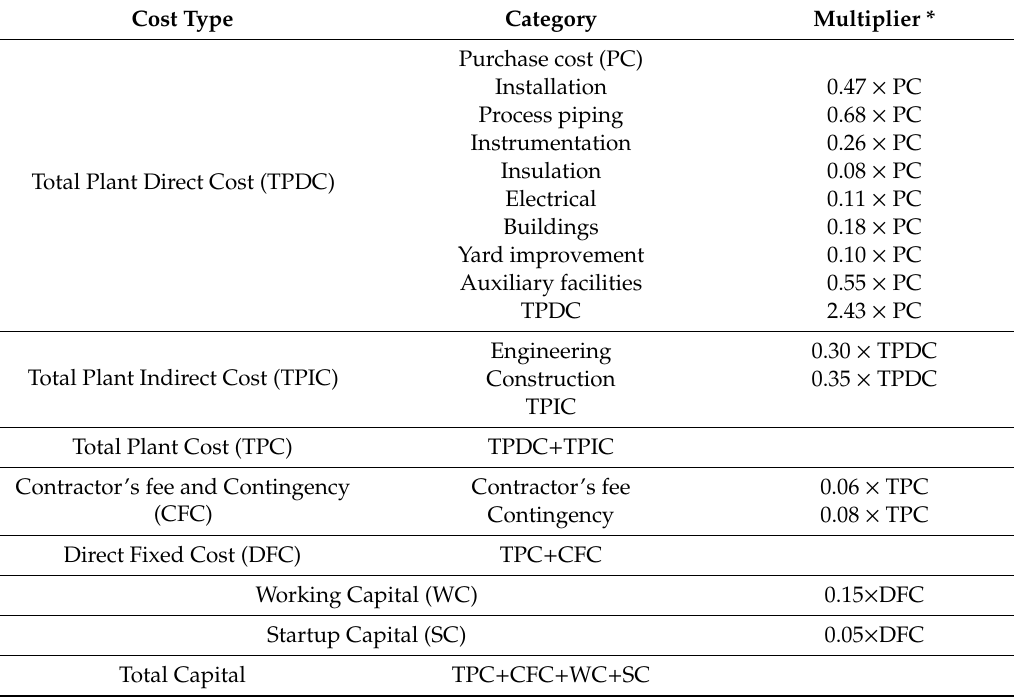
Table 1. Direct cost and total capital investment